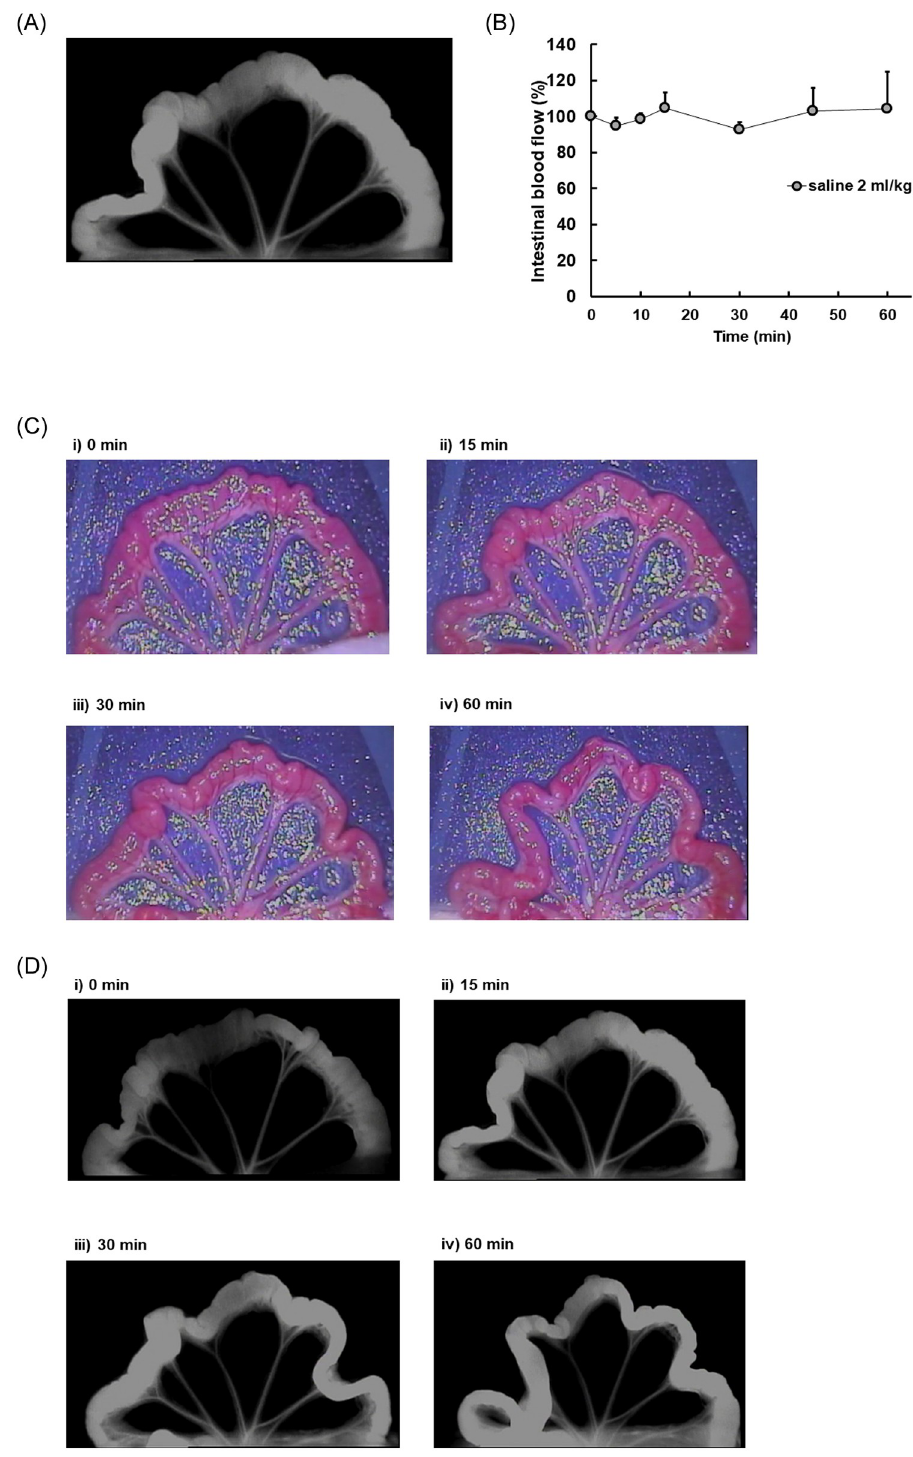
Fig 3. Intestine and mesentery after injection of ICG (A) and time course of intestinal blood flow after injection of saline (B). Visualization of the intestine after administration of theanine and a mixture of ingredients in a bright field (C) and a dark field (D) at 0, 15, 30 and 60 min. The three-branched part of blood vessels present in the mesentery (arrows) was selected for evaluation of the fluorescence intensity in each rat (A). ICG was administered by constant intravenous infusion from the tail vein at 5 mL/h with a syringe driver. At 15 min after the start of